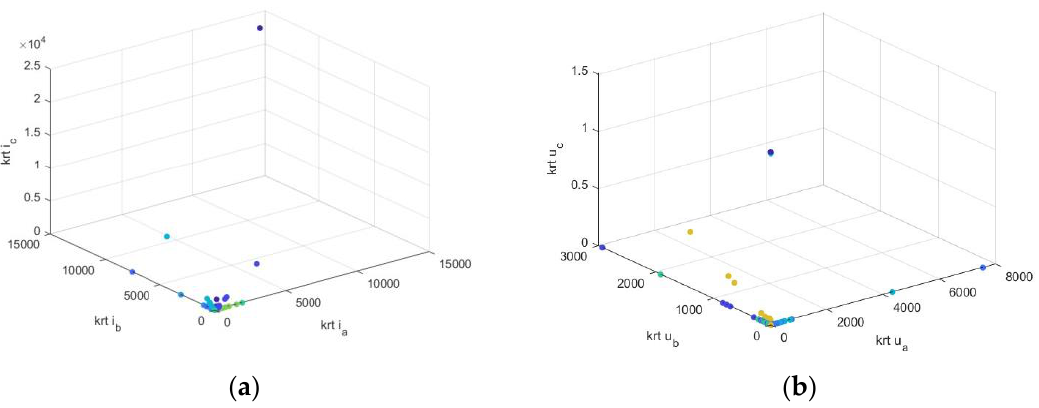
Figure 13. Dependence of the kurtosis of the ( a ) currents 𝑖 𝑎 , 𝑖 𝑏 , 𝑖 𝑐 and ( b ) voltages 𝑢 𝑎 , 𝑢 𝑏 , 𝑢 𝑐 .